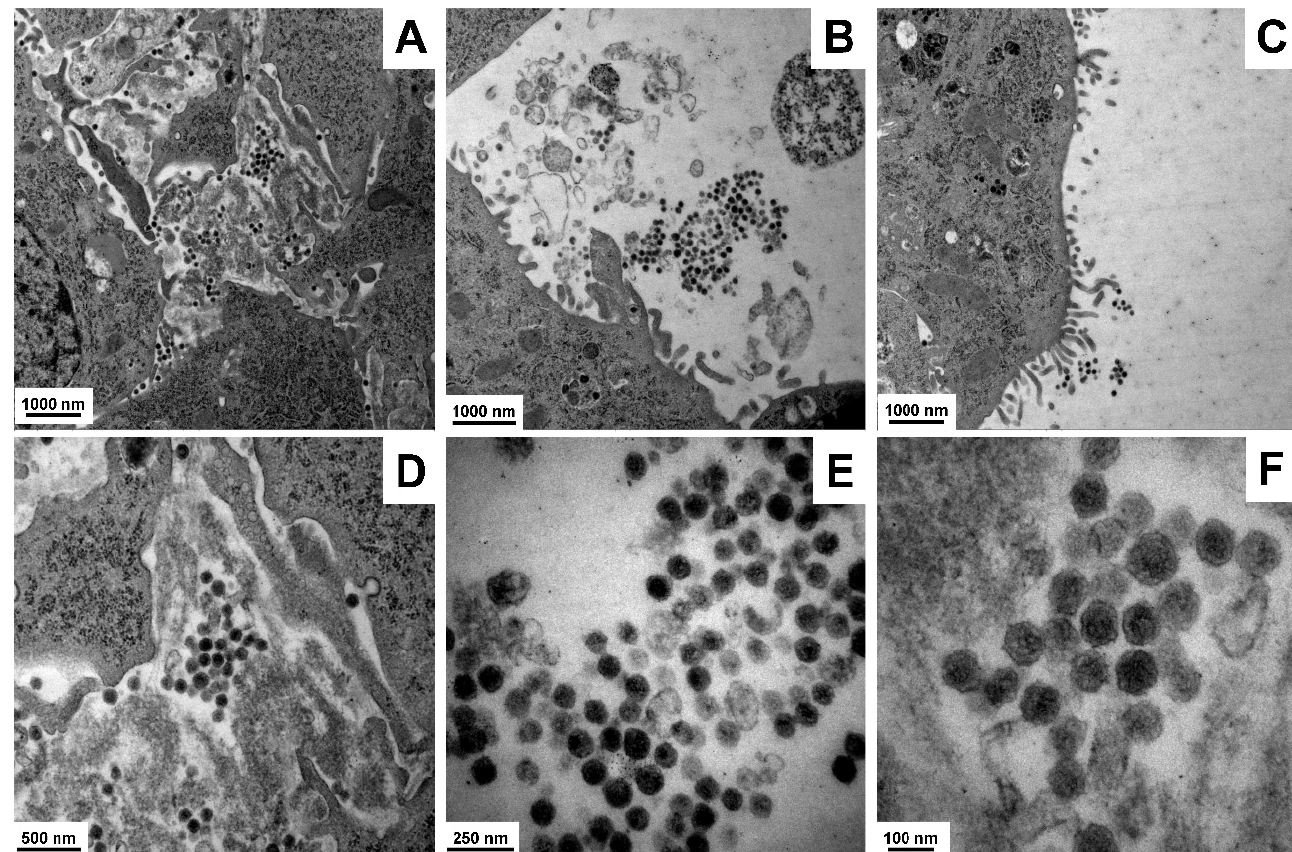
Figure 4. Retroviral load in GRX cells. ( A – F ) Representative images of retrovirus in GRX cultures are depicted. Magnifications: ( A , C ) 10,000 × , ( B ) 12,930 × , ( D ) 27,800 × , ( E ) 60,000 × , and ( F ) 100,000 ×.